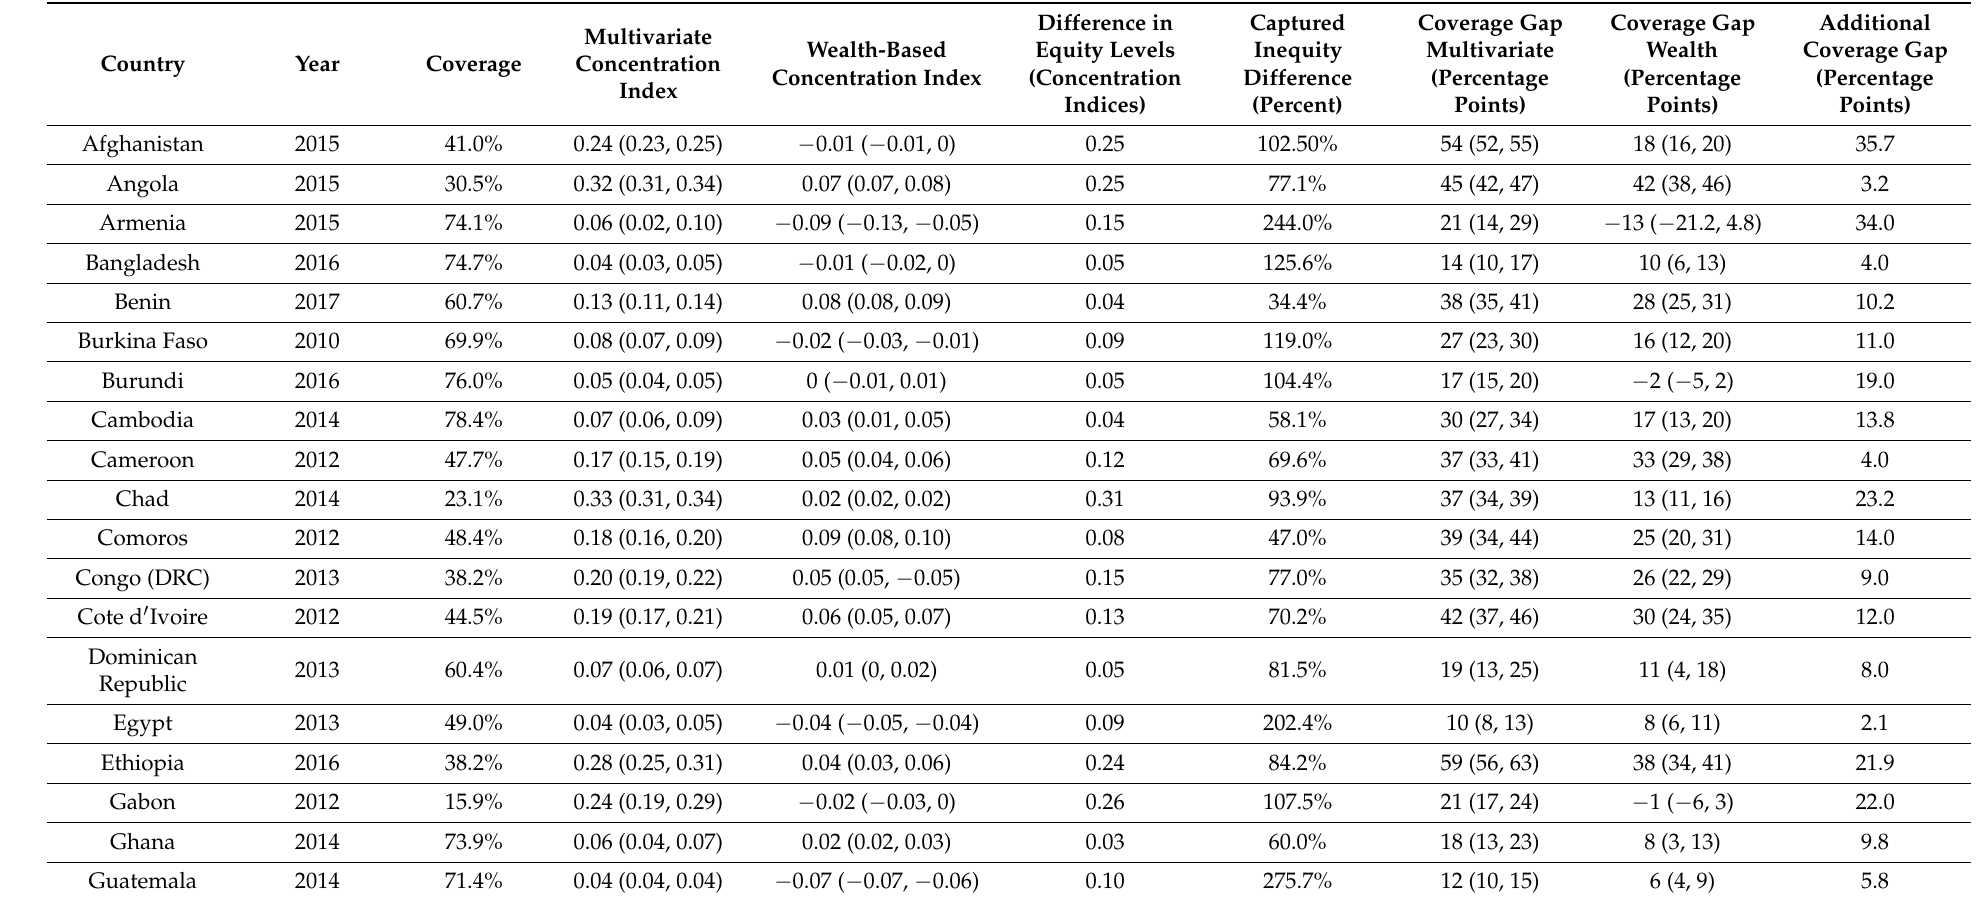
Table 2. Inequities in fully immunized status, by